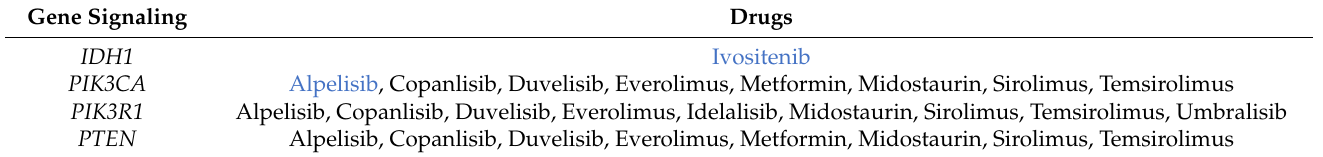
Table 2. FDA approved drugs targeting the signaling of four cancer-related genes of the lipid metabolism pathway. Drugs that specifically target only the corresponding gene are shown in blue